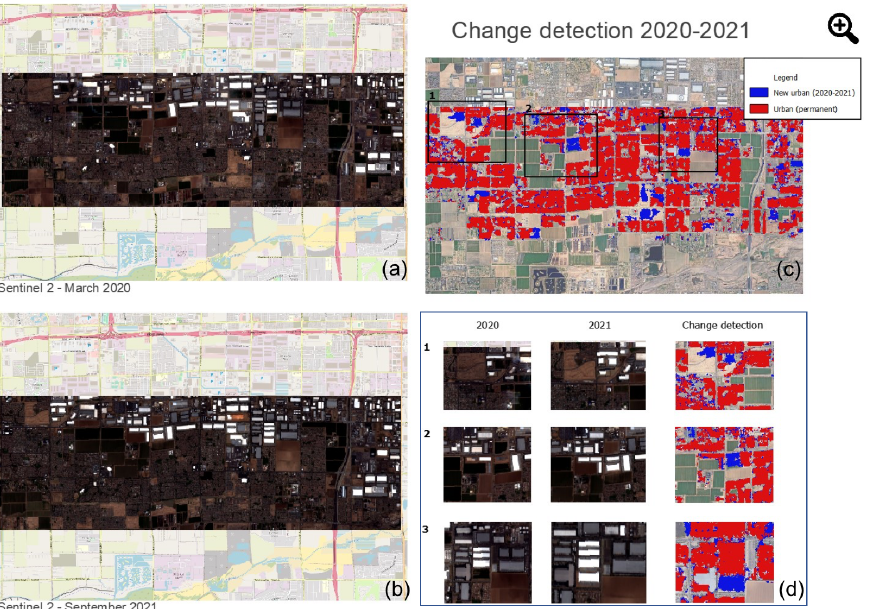
Figure 8. Detail of change map for the period March 2020 - September 2021. The first column shows a subset of Phoenix, respectively, on March 2020 ( a ) and September 2021 ( b ); the second column shows change detection results ( c ) and detail ( d ), where relevant changes are correctly detected (blue areas).